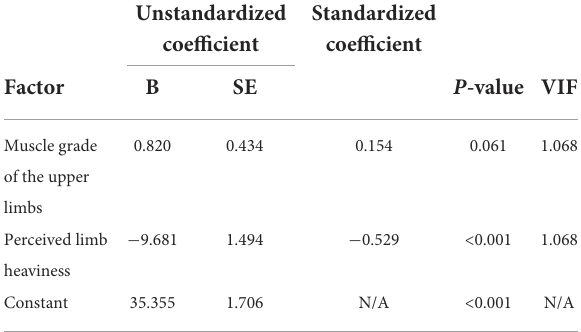
TABLE 2 Multivariate analysis of changes in rehabilitation adherence. TABLE 3 Comparison R 2 of the whole model and the model without limb